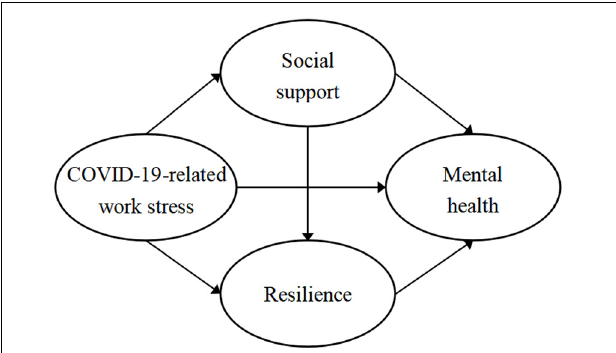
FIGURE 1 | Multiple mediating hypothesis model between variables. Hl, COVID-19-related work stress → Mental health; H2, COVID-19-related work stress → Social support → Mental health; H3, COVID-19-related work stress → Resilience → Mental health; H4, COVID-19-related work stress → Social support → Resilience → Mental